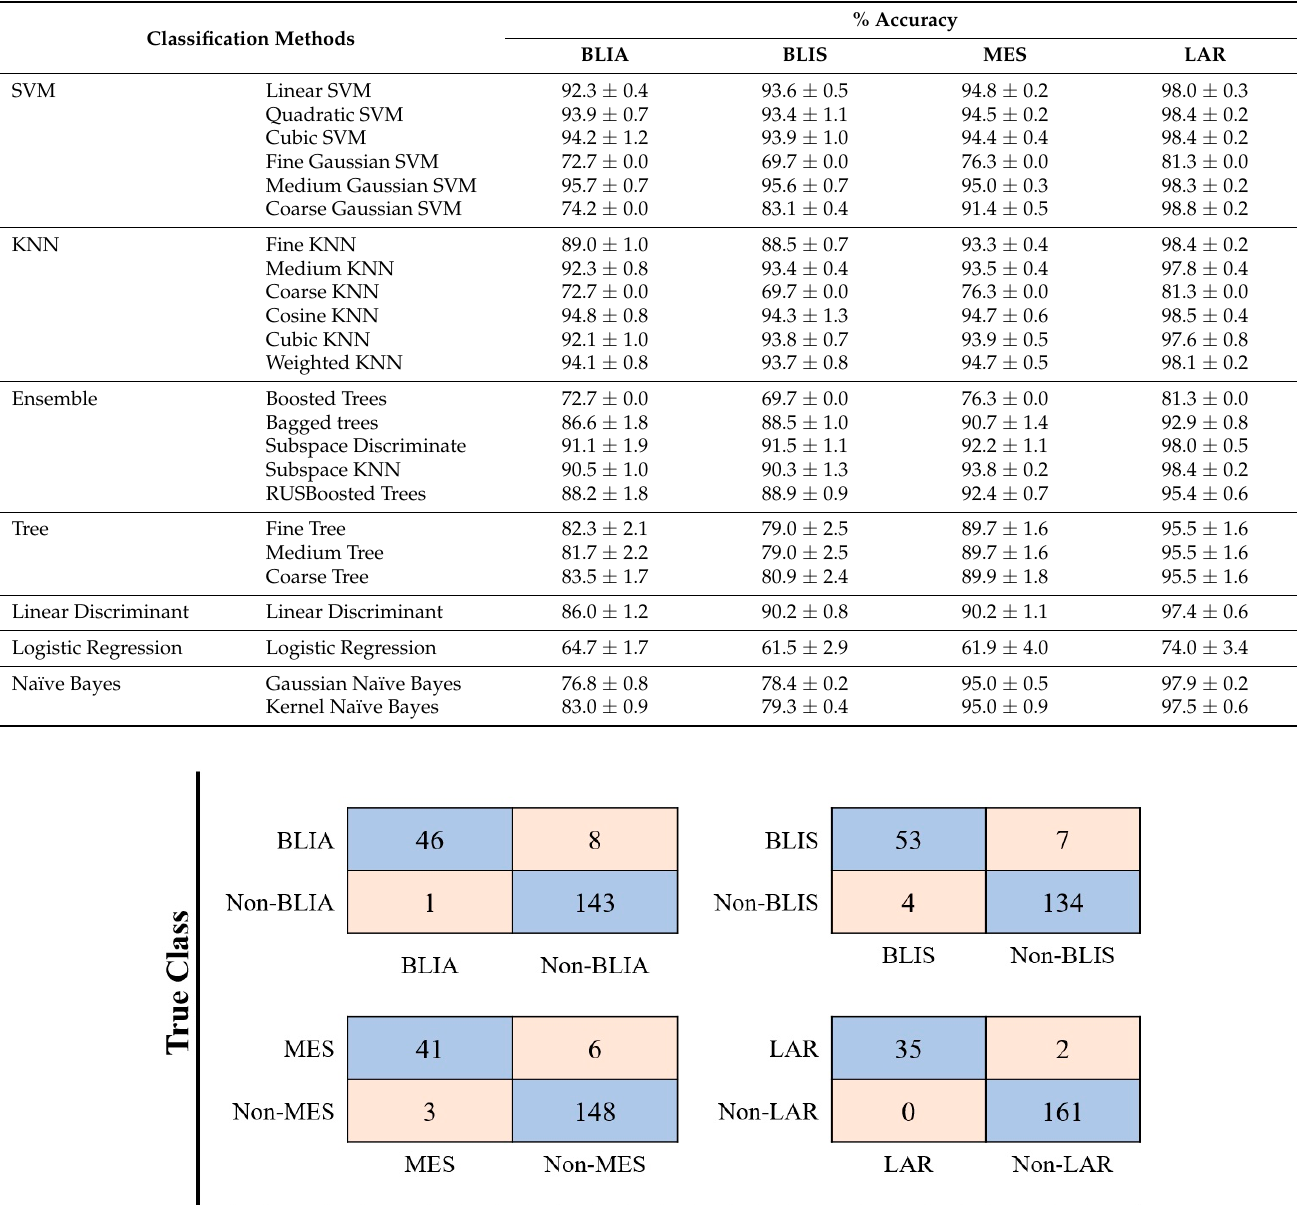
Table 2. Comparison of classification accuracy of all algorithms using 719 training genes.